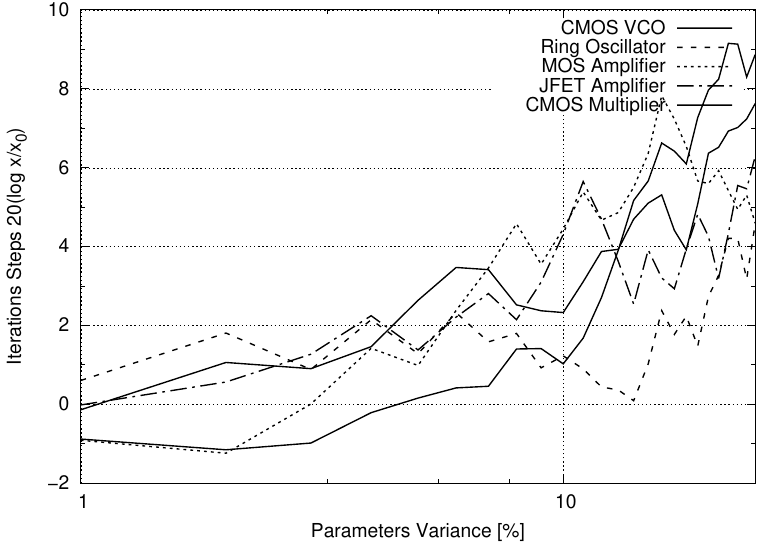
Figure 4. Dependence of the Number of Iterations on the Similarity to the Original Simulated